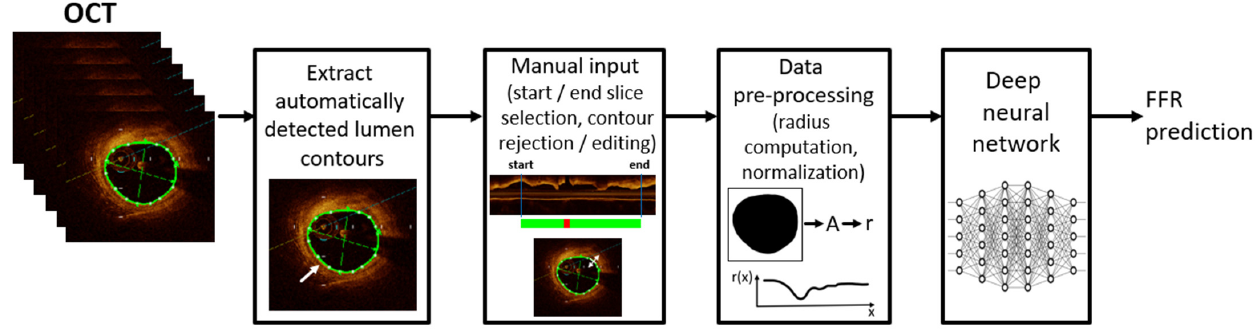
Figure 1. OCT data processing workflow, including FFR prediction using a deep neural network.